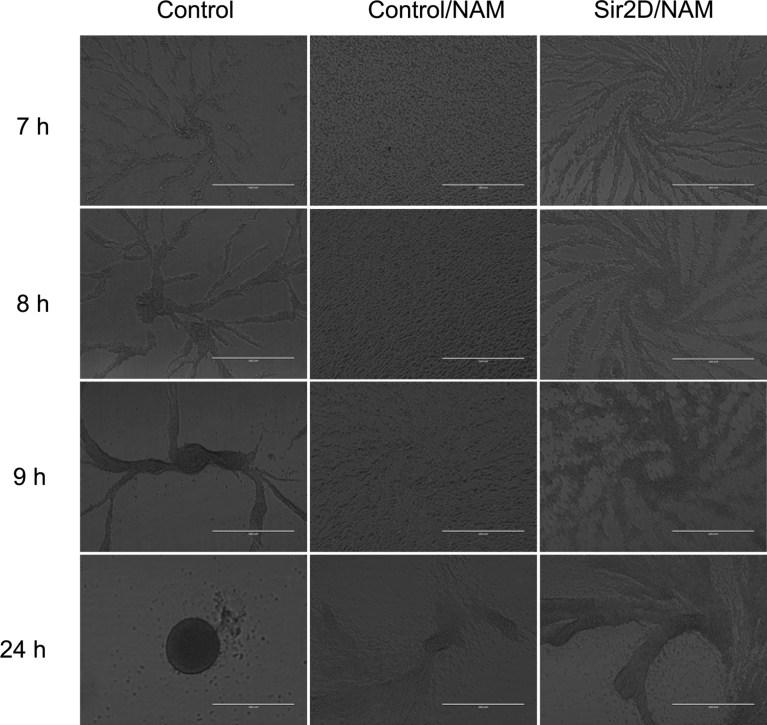
Supplementary Fig. S3.eps